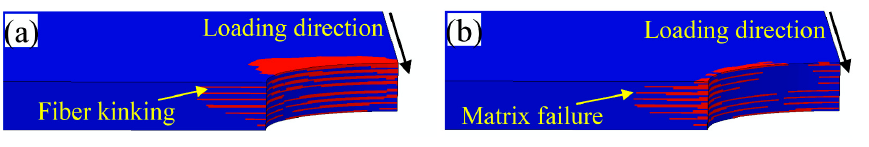
Figure 11. FEM results of hole circumference at B (( a ) fiber kinking, ( b ) matrix damage).